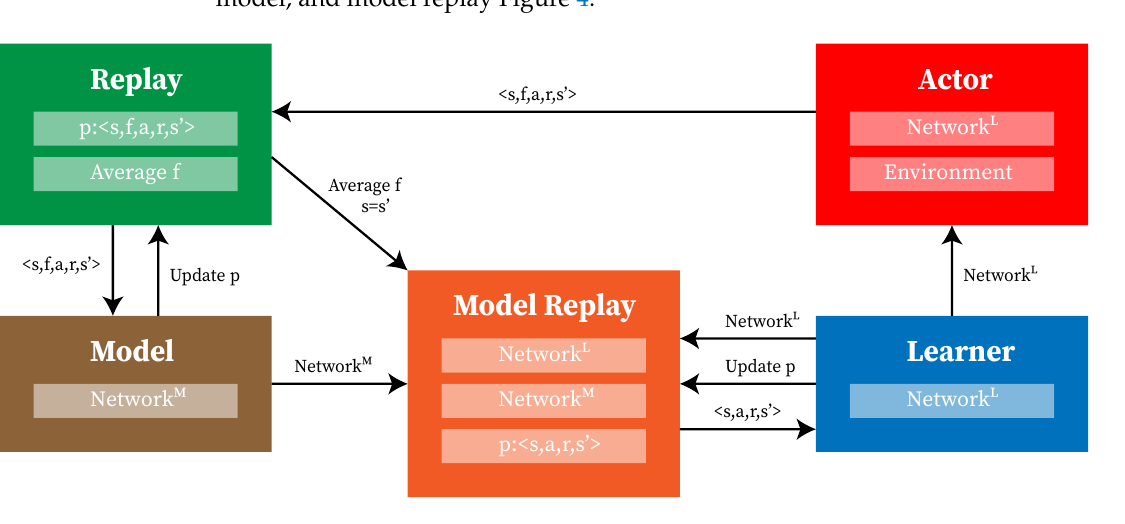
Figure 4. Method